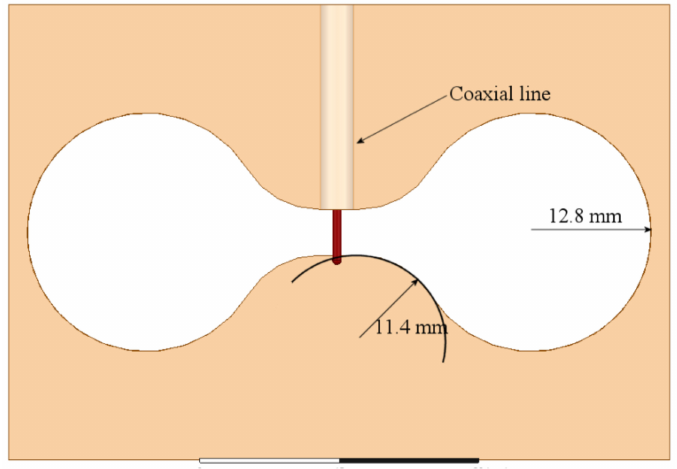
Figure 3. Modification of the rectangular slot to a circular dumbbell